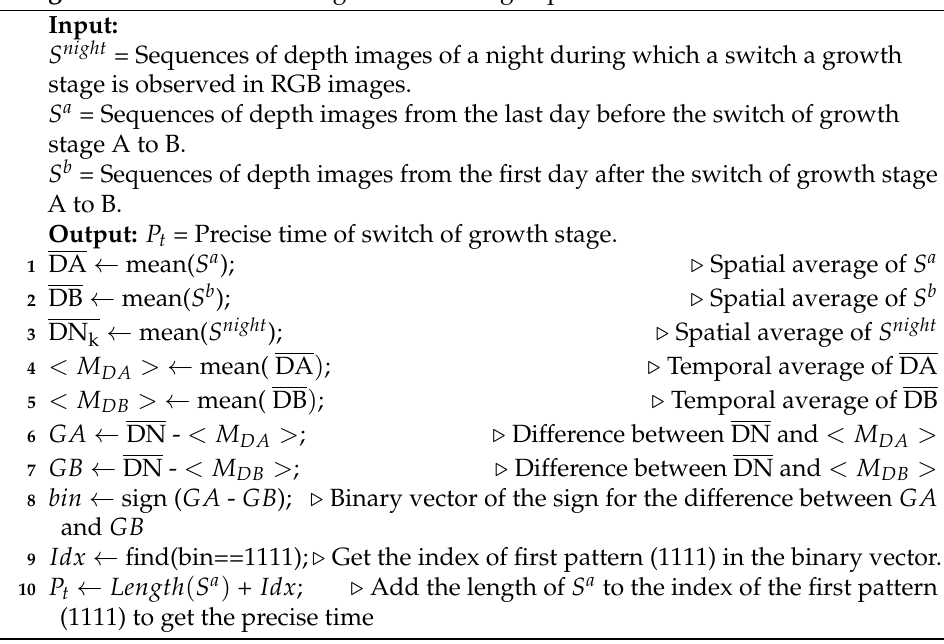
Figure 8. Histogram of detection of growth stage change during day and night from 4000 plants. Algorithm 1: Detection of night events using depth